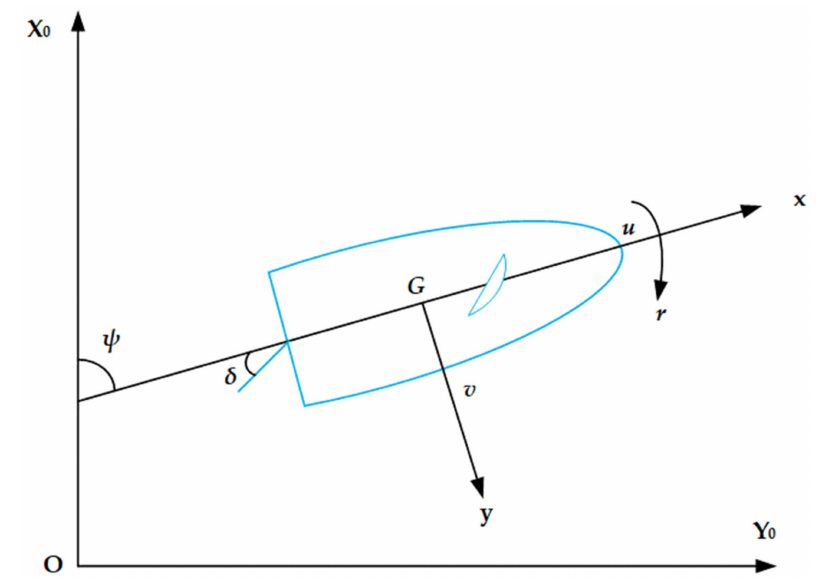
Figure 2. Ship motion coordinate